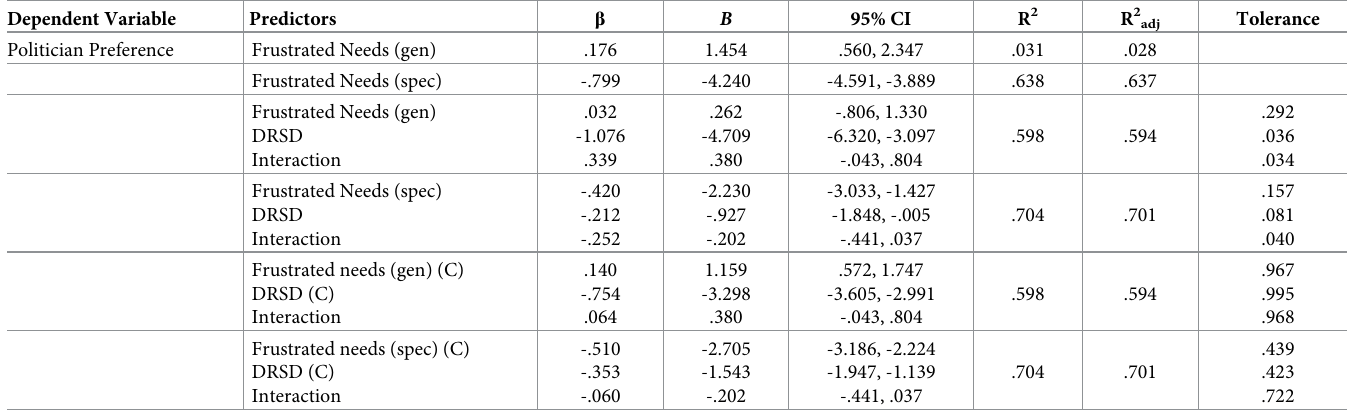
Table 7. Regression Analyses predicting politician